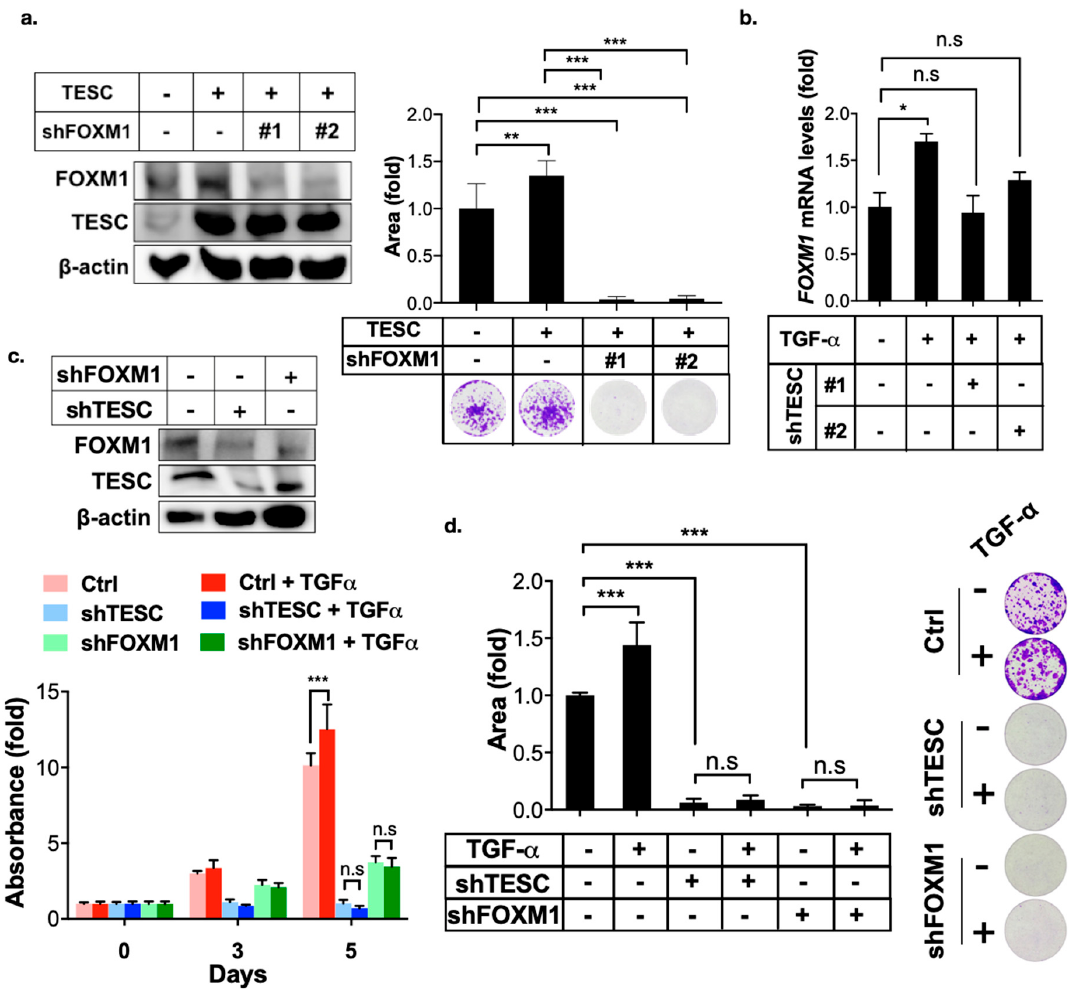
Figure 6. TESC mediates TGF- α -induced FOXM1 expression. ( a ) Clonogenic assays were employed to assess the e ff ect of FOXM1 silenced on TESC-overexpressed HUCCT1 cells. HUCCT1 cells were first infected with lentiviral vectors encoding TESC or vector control for 5 days, followed by infection with lentiviral vectors encoding shTESC or scrambled control for 2 weeks. The levels of TESC and FOXM1 were determined by immunoblotting (left). Colonies were stained with crystal violet and quantified (upper right). Representative plates were photographed (bottom right). ** p < 0.01, *** p < 0.001. ( b ) qPCR analysis of FOXM1 expression in HUCCT1 cells infected with or without shTESC in the presence TGF- α (50 ng / mL) for 4 h. * p < 0.05, n.s.: no significance. ( c ) MTT assay of proliferation of HUCCT1 cells infected with shTESC as well as shFOXM1 or control vector in the presence or absence of TGF- α (50 ng / mL). The levels of TESC and FOXM1 were determined by immunoblotting (upper). *** p < 0.001, n.s.: no significance. ( d ) Clonogenic assays of HUCCT1 cells infected with lentiviral vectors encoding shTESC, shFXOM1, or scrambled control in the presence or absence of TGF- α (50 ng / mL) for 2 weeds. Left: Colonies were stained with crystal violet and quantified. Right: Representative plates. *** p < 0.001, n.s.: no